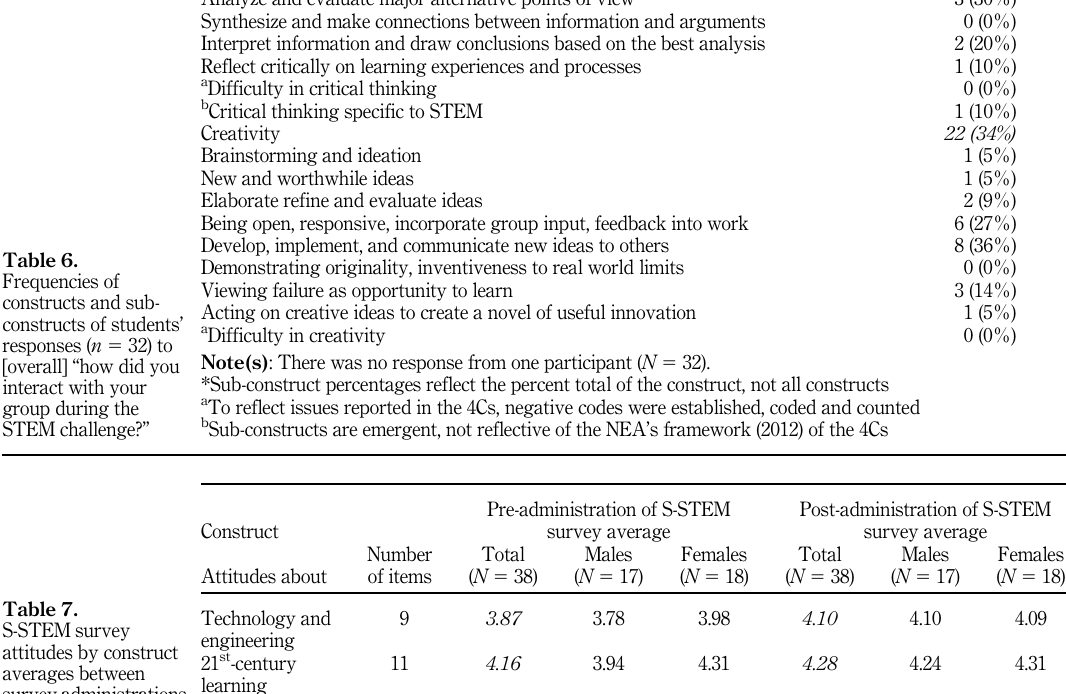
attitudes by construct averages between survey administrations disaggregated by gender (male and